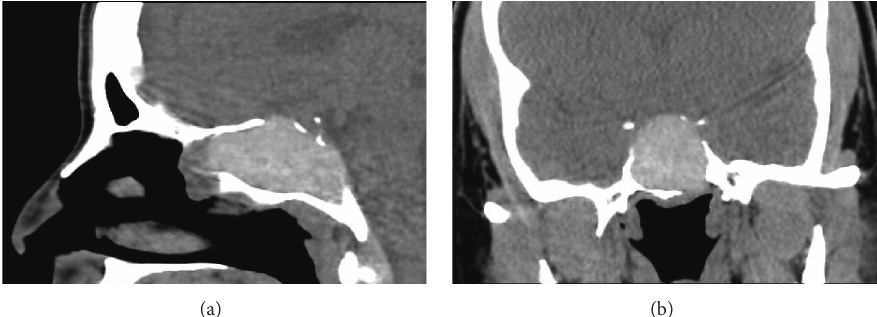
Figure1:SinusCTwithsagittal(a)andcoronal(b)reconstructionsdemonstratinga5.0 × 2.7 × 2.5 cmhyperdensesphenoidmasswithmarked sphenoid expansion, suggestive of allergic fungal sinusitis. There is erosion of the sella, clivus, and a portion of the planum sphenoidale.